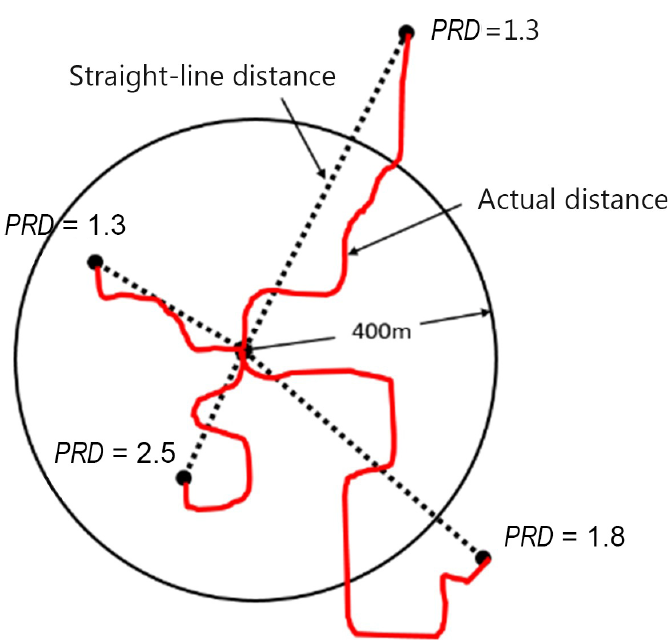
Figure 12. Pedestrian Route Directness ( PRD ).